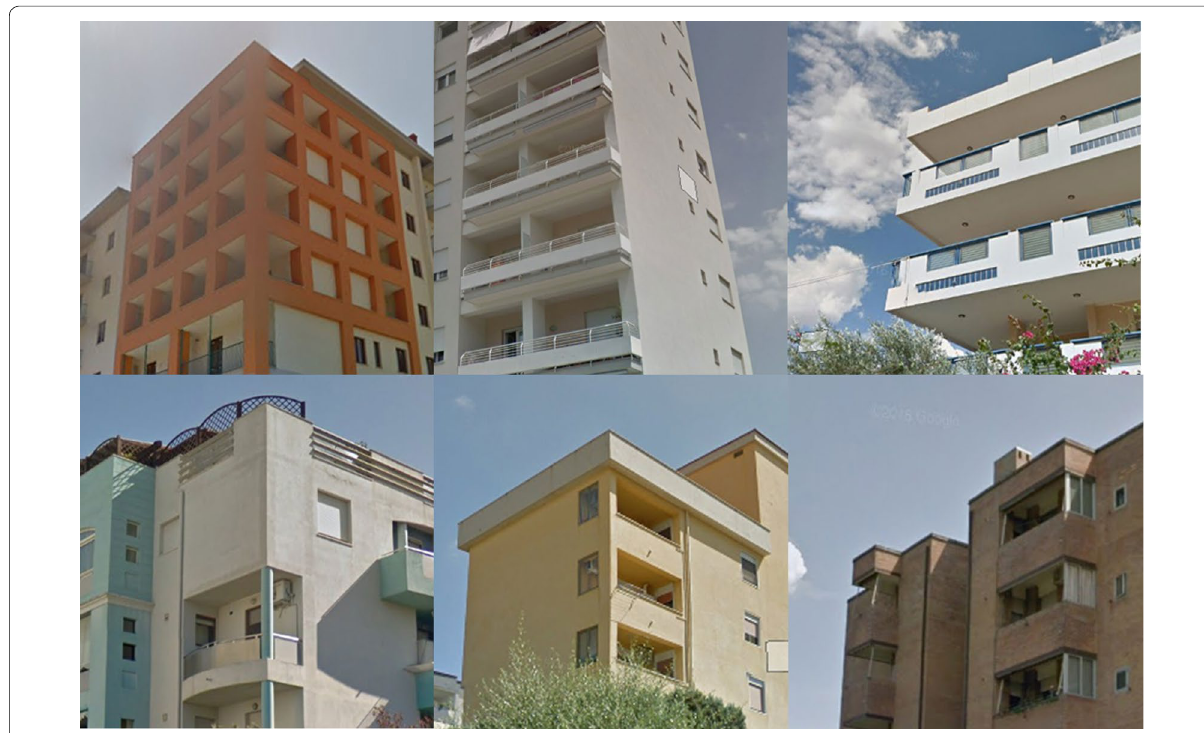
Fig. 5 Nomotropic architectures. From the upper left-hand corner: Avellino, Salerno, Cagliari, Quartucciu, Agrigento and